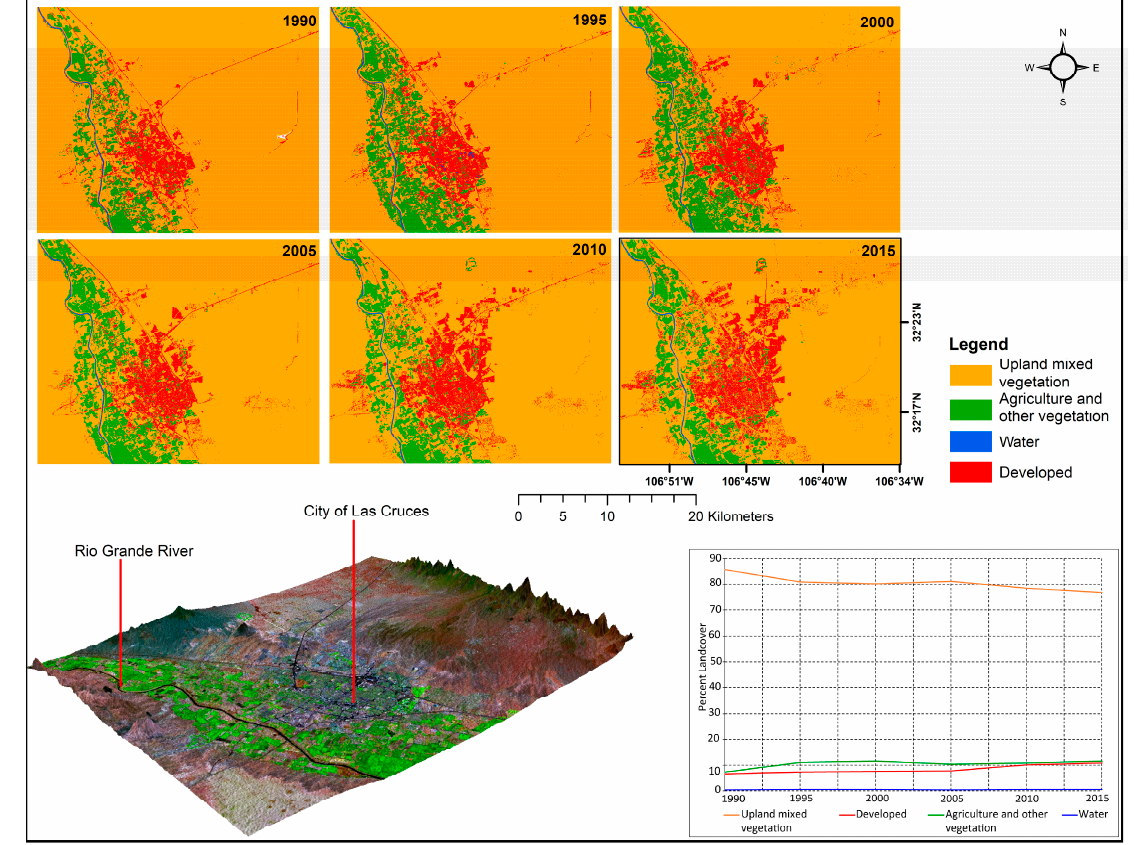
Figure 6. Land use change around the City of Las Cruces, 1990–2015.